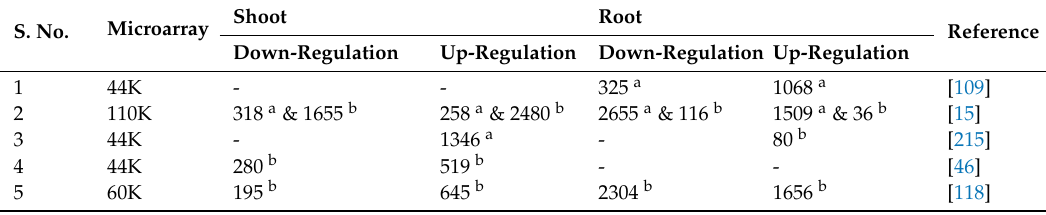
Table 3. Up- and down-regulation of a list of genes for FD and FT